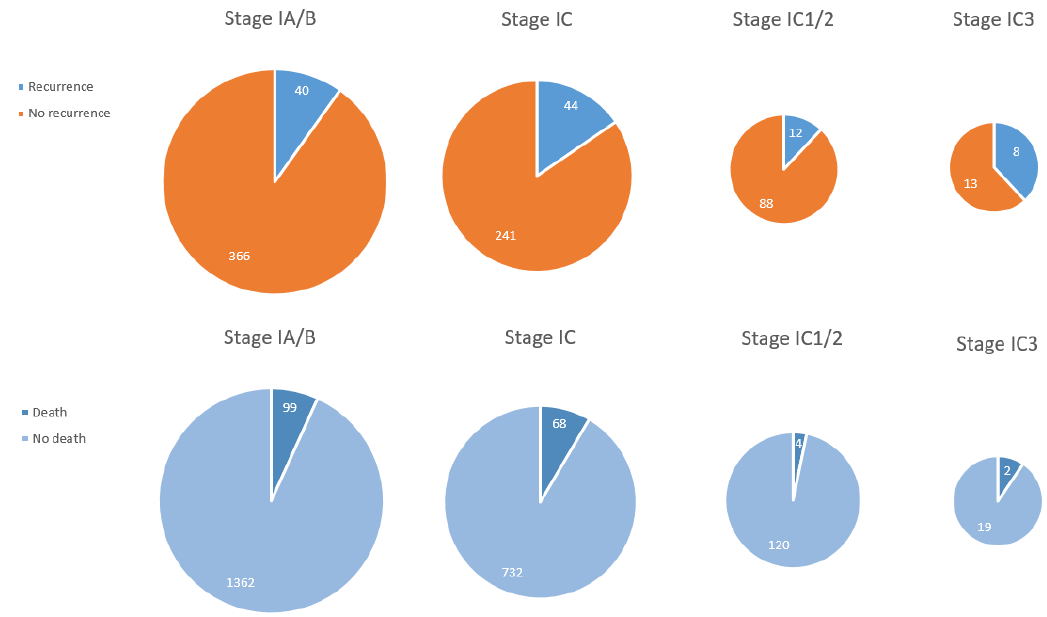
Figure 2. Recurrence rate and death rate in epithelial ovarian cancer per FIGO stage. Death rate was 6.8% (99/1461) in stage IA/B versus 8.5% (68/800) in stage IC ( p = 0.134), 3.2% (4/120) in stage IC1/2 versus 9.5% (2/21) in stage IC3 ( p = 0.209), and 7.2% (168/2154) in stage I versus 39.2% (250/387) in stage ≥ II ( p ≤ 0.001) (Figure